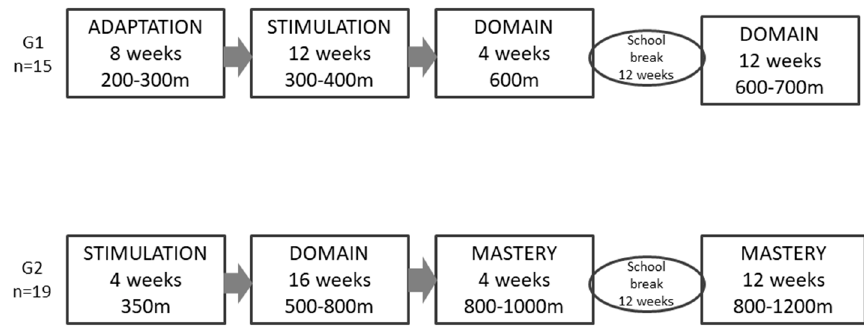
Figure 2. Groups of swimming development.